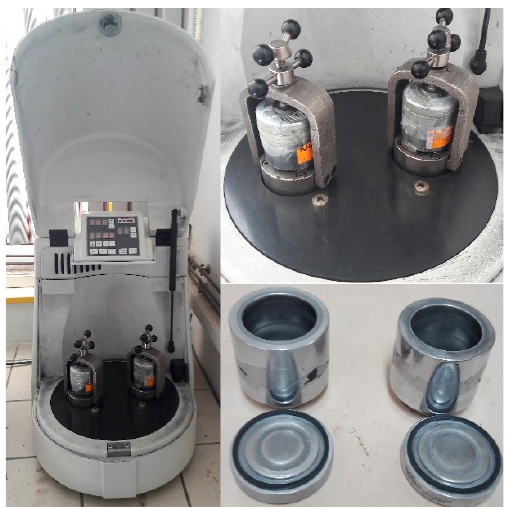
Figure 1. P7 planetary ball mill and milling media used in the experiments.